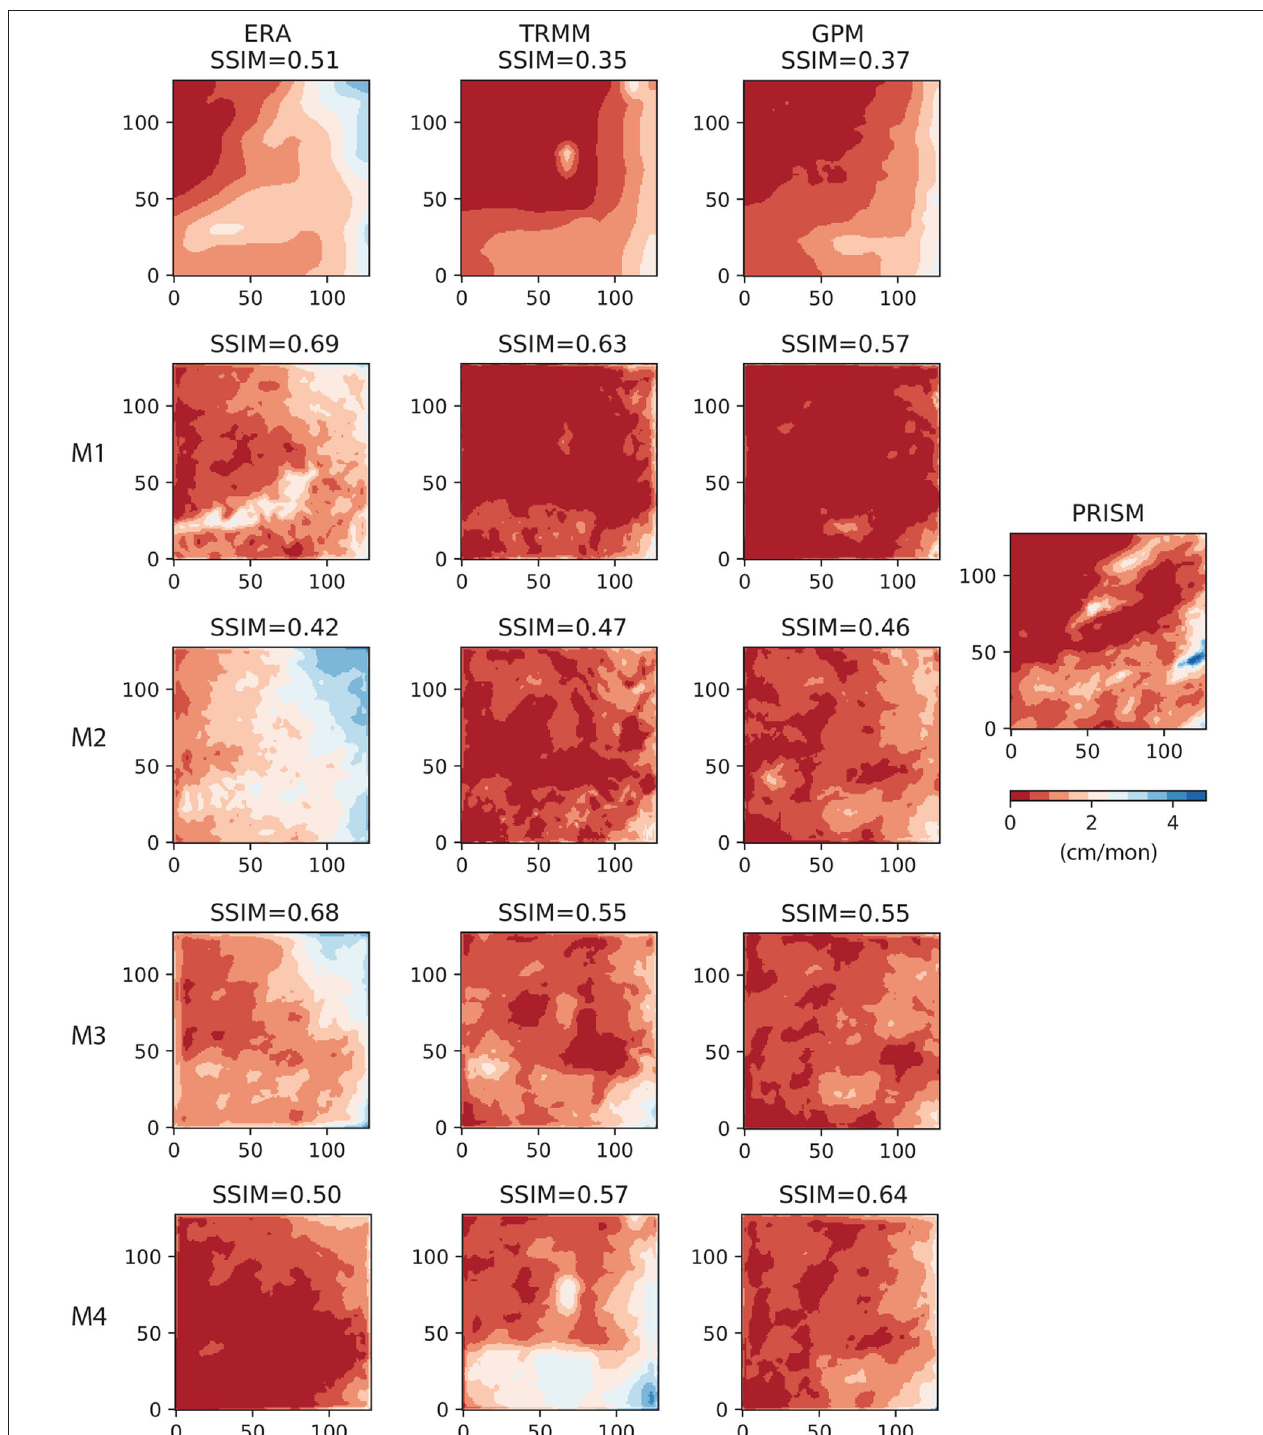
FIGURE 10 | AU-Net results on 2018/01 data (128 × 128 grid). Left column (from top to bottom): ERA5 and the corresponding M 1 − M 4 AU-Net models; 2nd column: TRMM and the corresponding AU-Net models; 3rd column: GPM and the corresponding AU-Net models; rightmost column: PRISM data for the same month.